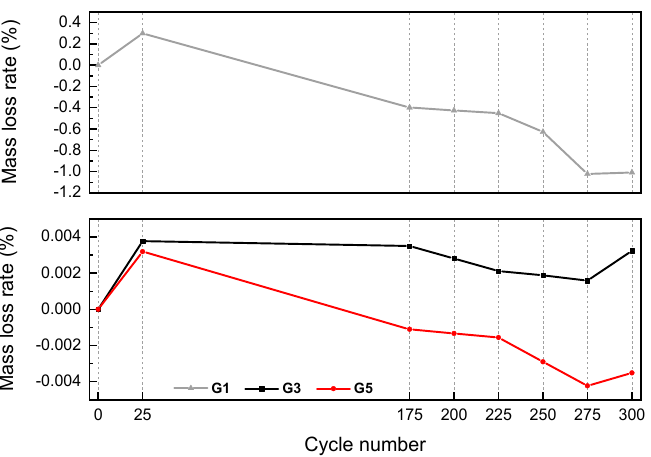
Figure 5. Mass loss after different freeze–thaw cycles (note: the plus and minus directions of the Y axis represent the increase and decrease in mass, respectively).